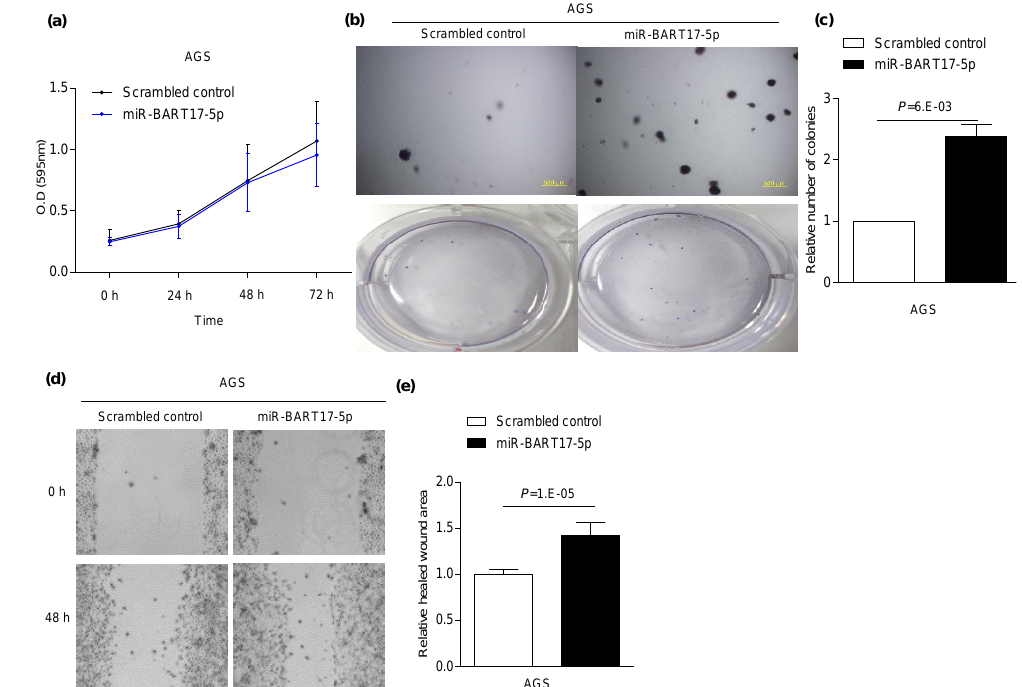
Figure 4. Enhanced AGS cell migration and anchorage-independent growth by miR-BART17-5p. AGS cells were transfected with 30 nM miR-BART17-5p mimic ( a–e ). ( a ) Before and every 24 h after miR-BART17-5p mimic transfection, 20 µ L of MTT solution was added to each well to assess AGS cell proliferation. Experiments were conducted four times independently. ( b ) For conducting soft agar colony formation assay, transfected AGS cell was harvested after 24 h and seeded in agar. Cells placed in agar were observed after 4-6 weeks in three independent experiments. Upper panels were observed with microscope IX70 (Olympus, Tokyo, Japan) through a × 40 objective. Lower panels show the pictures taken with a camera. ( c ) Colonies were quantified using Image J software. Error bars indicate SD ( n = 3). ( d ) Wound-healing assay was performed using AGS cells transfected with either miR-BART17-5p or the scrambled control. ( e ) Healed wound area was measured by Image J software. Error bars indicate SD ( n =